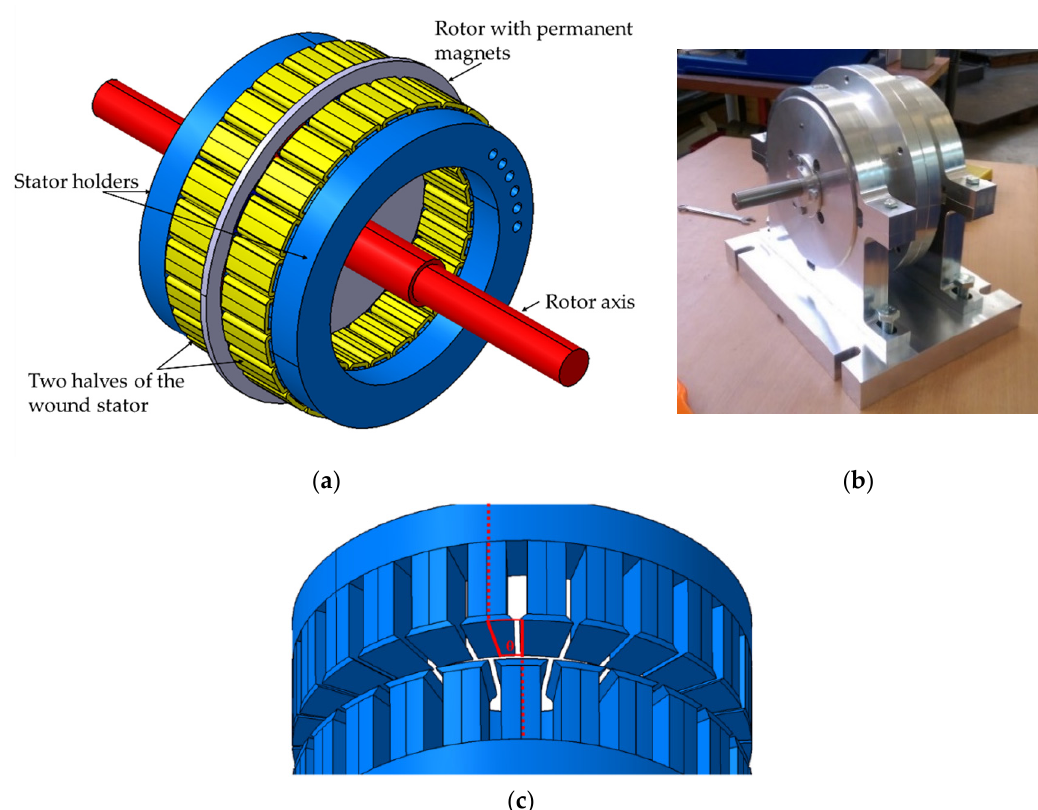
Figure 2. ( a ) Internal design of axial flux permanent magnet (AFPM); ( b ) AFPM generator yoke; ( c ) Relative angle between two halves of a stator.